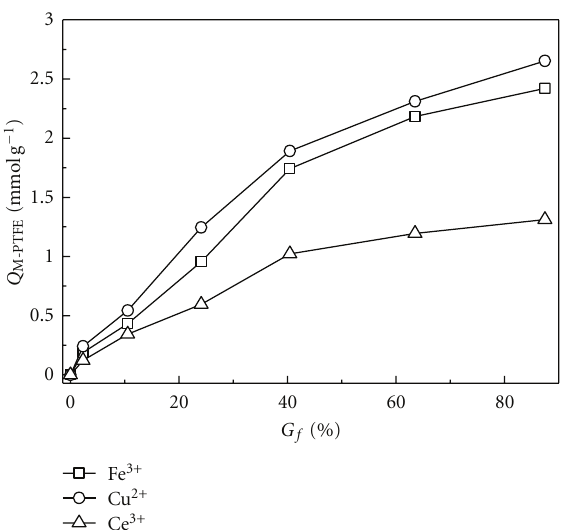
Figure 3: Q M-PTFE of the complexes as a function of graft degree of PAA-g-PTFE.